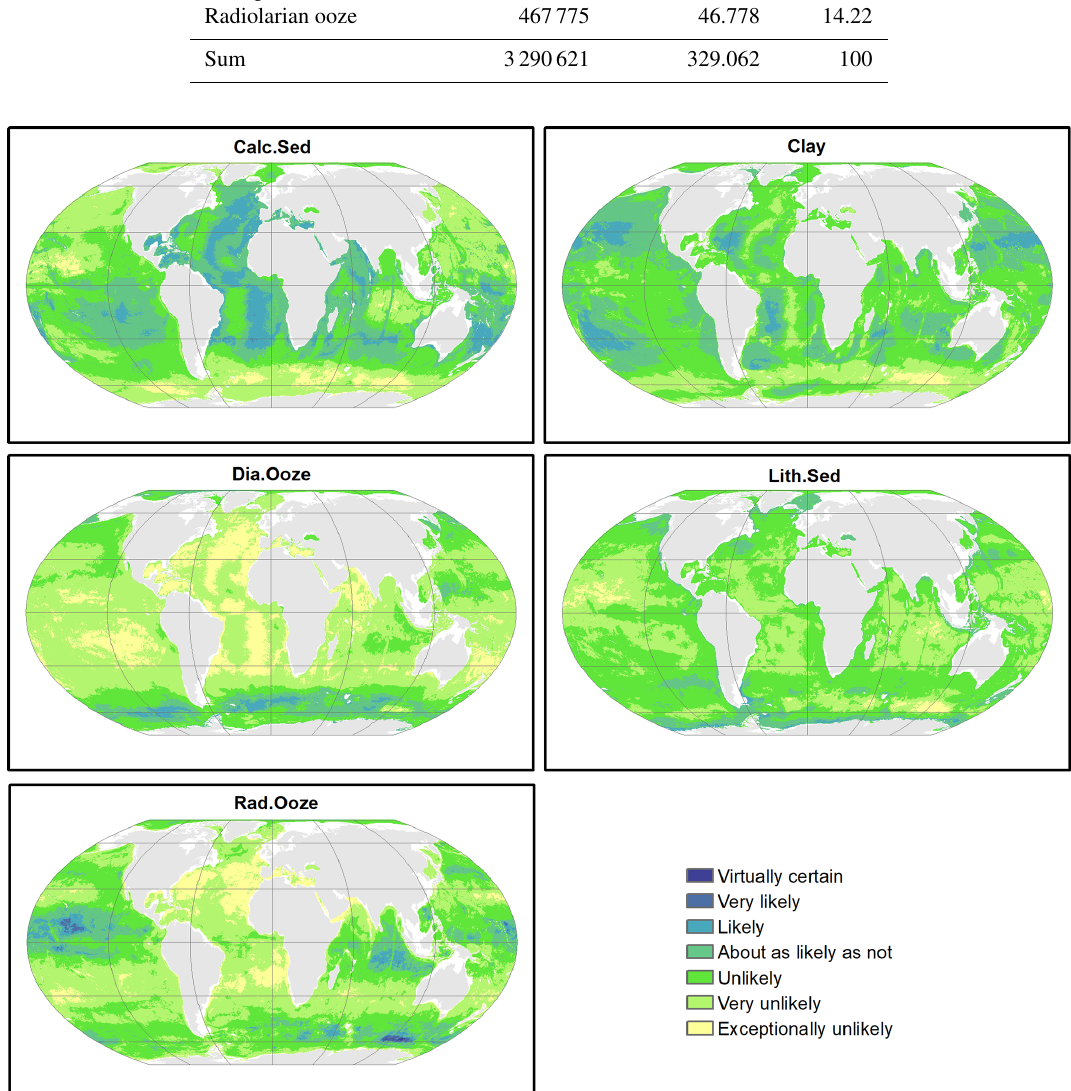
Figure 6. Probability surfaces of the five predicted lithologies. The verbal likelihood scale is based on Mastrandrea et al. (2011). Land masses are derived from ESRI